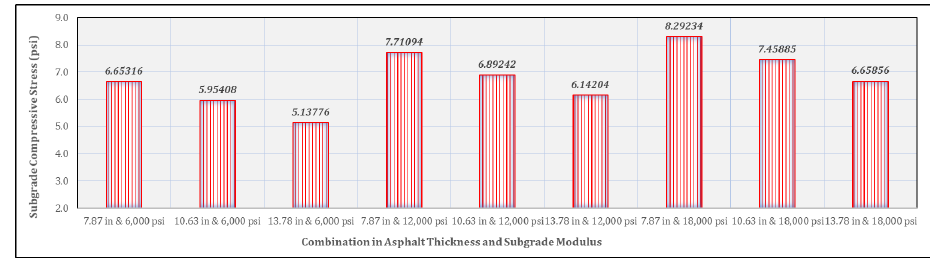
Figure 29: Influence of subgrade modulus and asphalt thickness on subgrade compressive stress in asphaltic overlayment rail track.